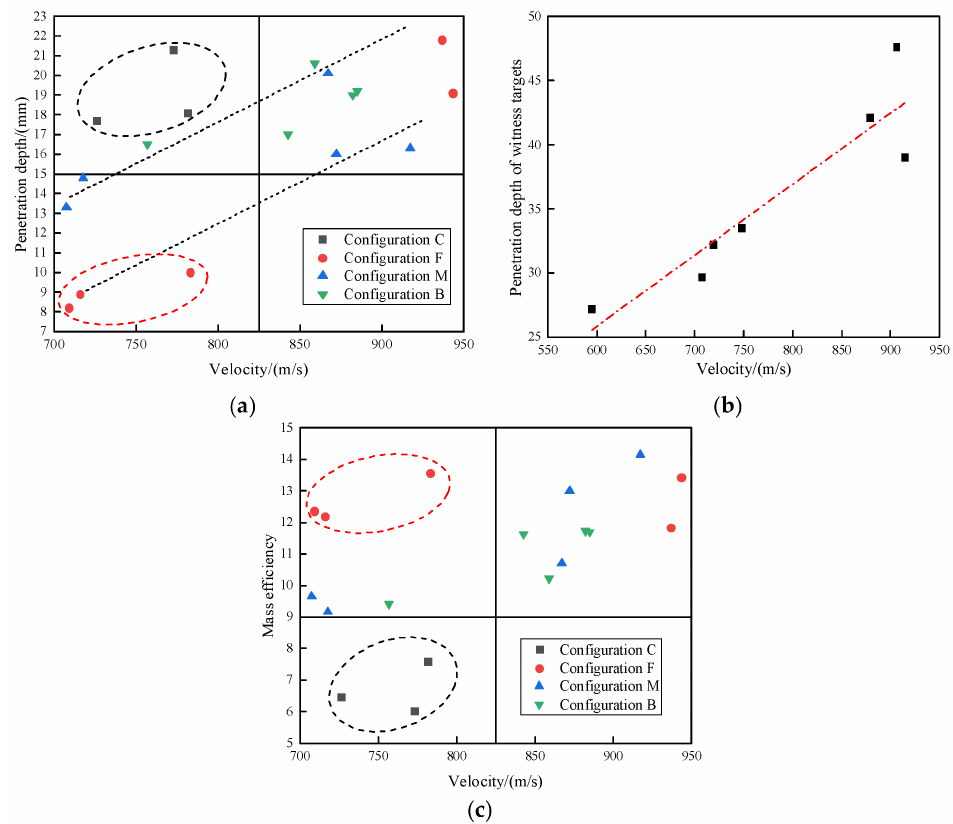
Figure 4. Penetration depth of the different targets. ( a ) Penetration depth. ( b ) The penetration depth of the reference test. ( c ) Effectiveness of the targets.